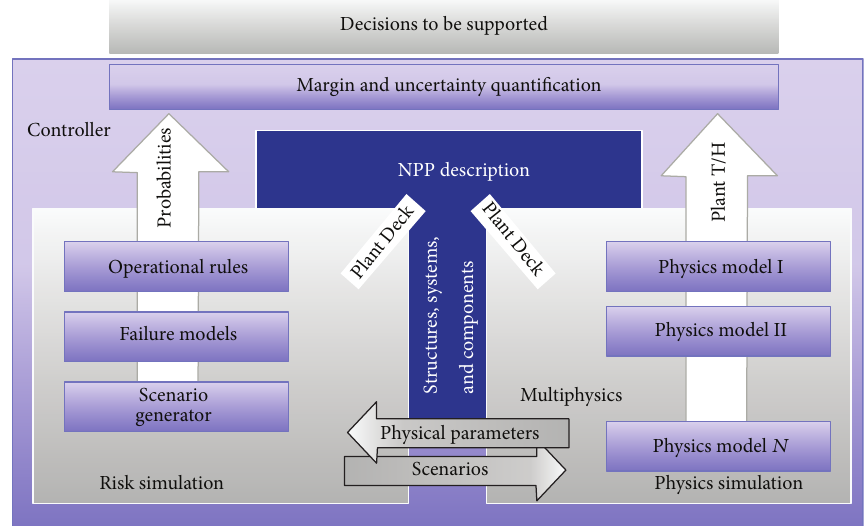
Figure 1: The approach used to support RIMM analysis.